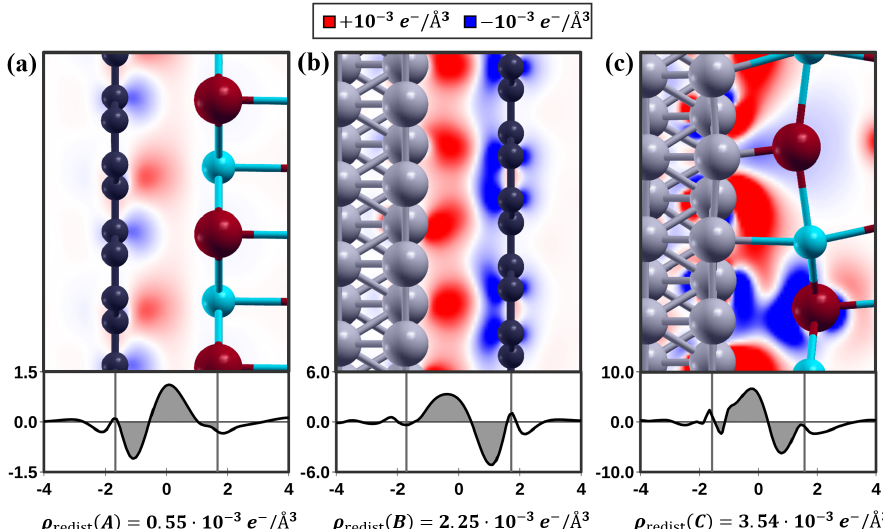
Figure 5. Top: charge density differences ρ diff of ( a ) KBr on Gr, ( b ) Gr on Ir(111) and ( c ) KBr on Ir(111). Red and blue regions represent charge accumulation and depletion, respectively. Bottom: ¯ ρ diff ( z ) , i.e., planar averages of ρ diff The horizontal axis indicates the height in angstrom and is centered on the middle of the interface. The vertical axis indicates the values ¯ ρ diff ( z ) multiplied by 10 3 . The amount of redistributed charge, ρ redist , is indicated by the gray shaded areas on the graph